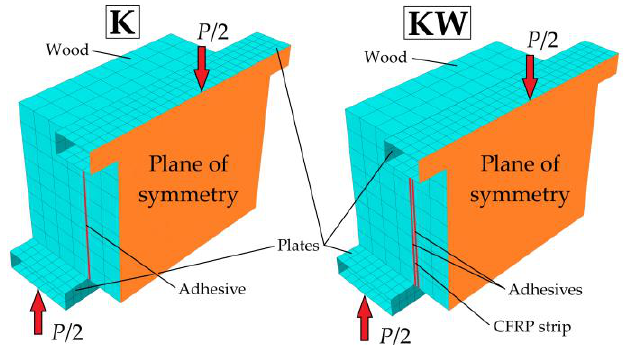
Figure 15. Finite element (FE) models of the adhesive connections.